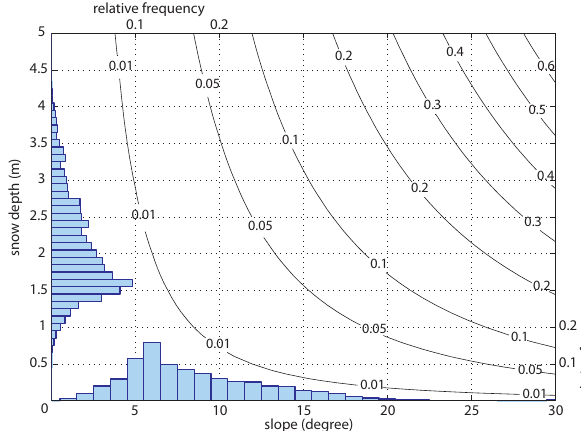
Fig. 5. Contour lines of the correction of GPR snow depth as a func- tion of slope and snow depth. The relative frequency distribution of GPR snow depths h v and the frequency distribution of the occurring slopes are presented in horizontal and vertical bars,